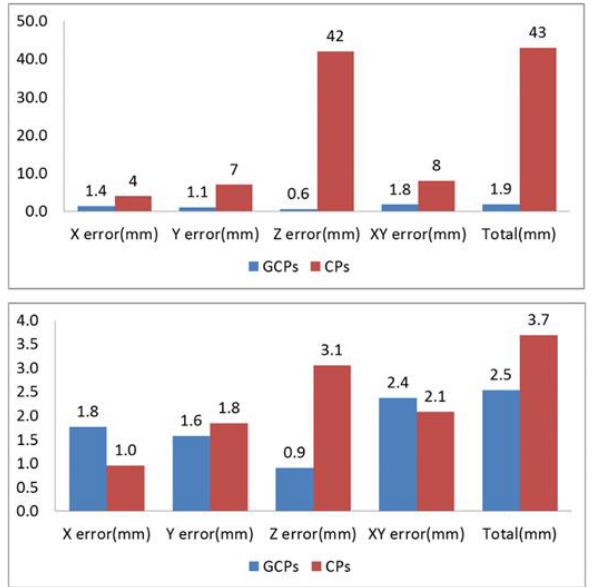
Fig. 7: RMSE values at GCPs and CPs for configurations K1 (top) and K2 (bottom) using laboratory calibration. Note the different scaling.